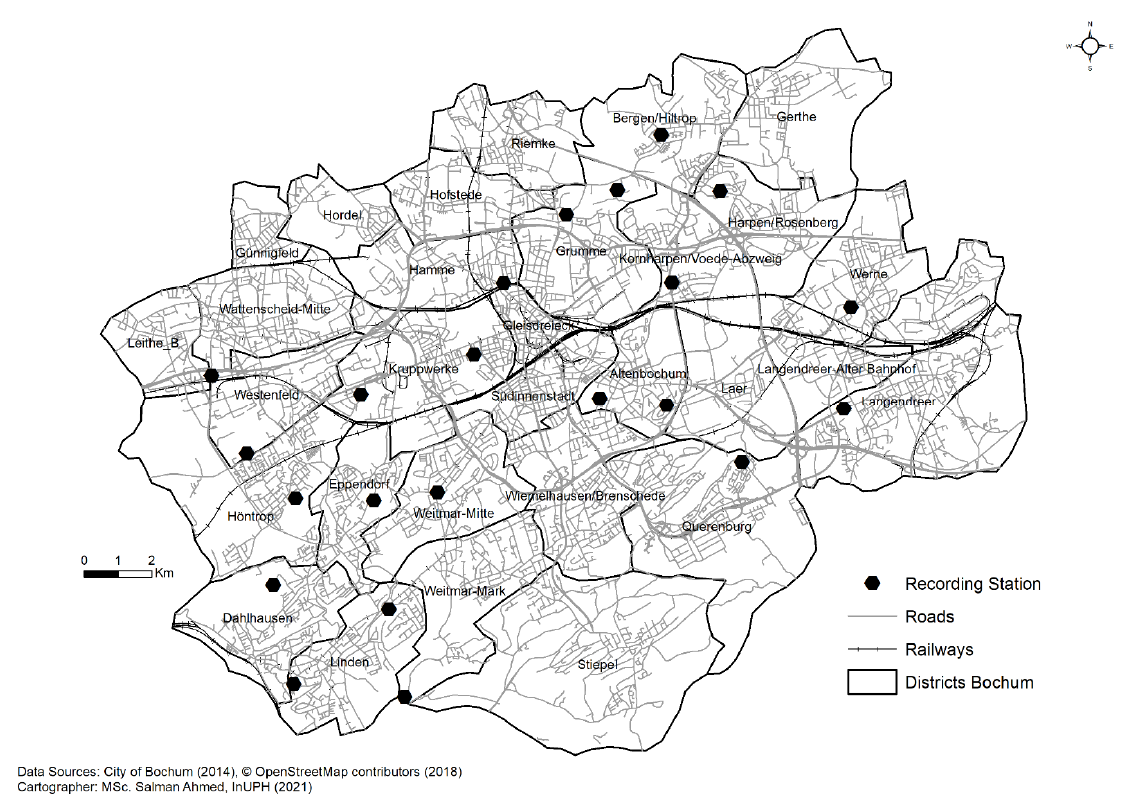
Figure A1. Recording stations in Bochum.